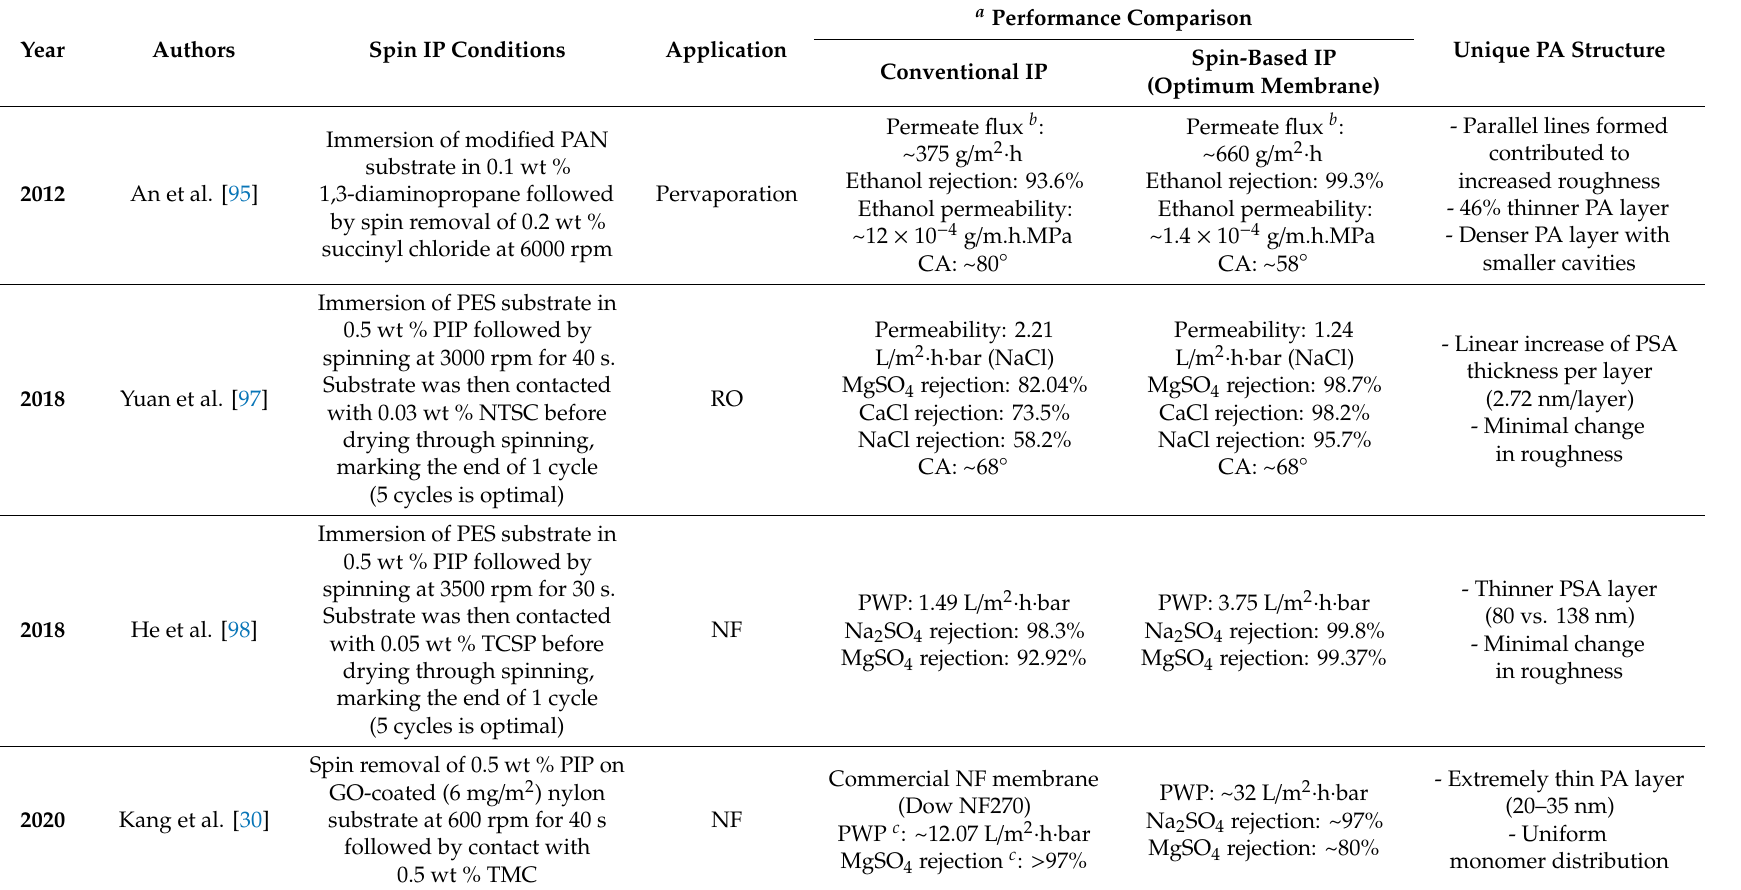
Table 3. Comparison of TFC / TFN membranes fabricated by using conventional and spin-based